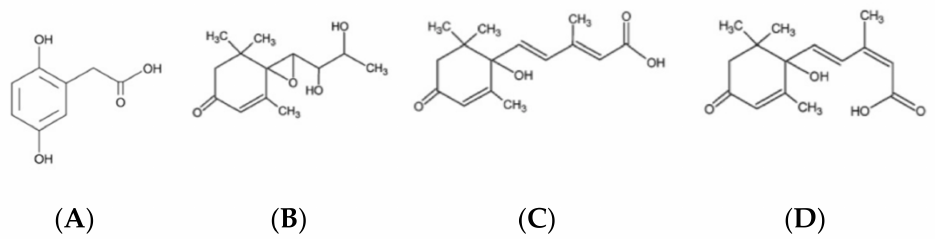
Figure 5. Structures of floral markers of Sardinian bitter honey: ( A ) homogentisic acid (2,5- Dihydroxyphenylacetic acid) ( B ) unedone, ( C ) ( ± )-2- cis ,4- trans -abscisic acid, ( D ) ( ± )-2- trans ,4- trans - abscisic acid)